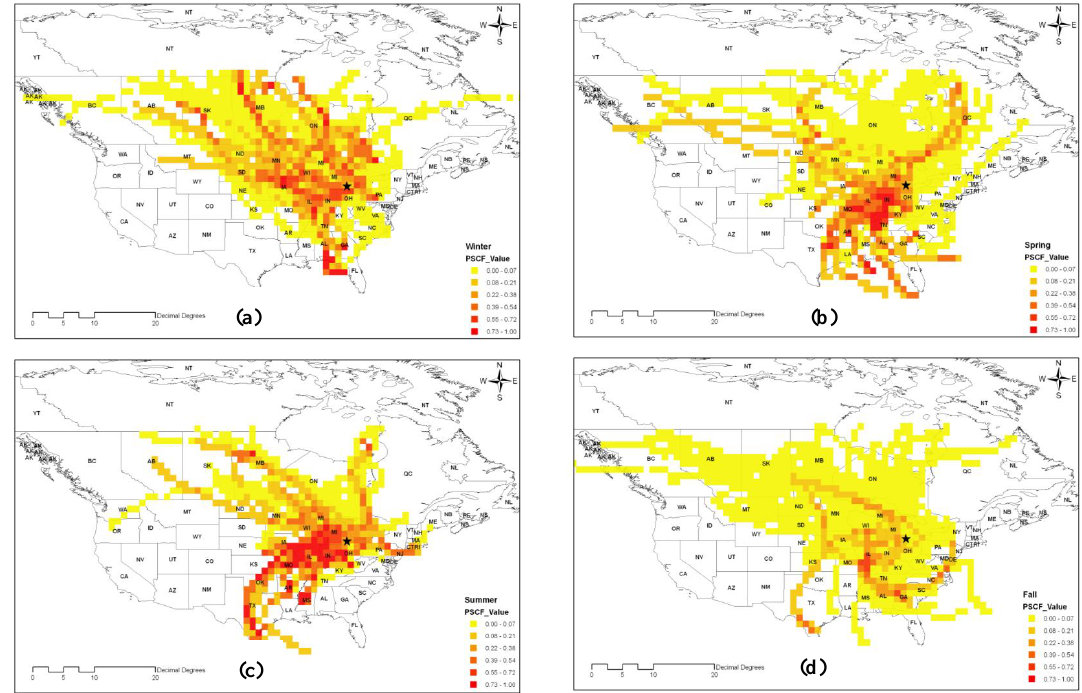
Fig. 5. Weighted PSCF for Windsor in (a) winter, (b) spring, (c) summer and (d) fall, using the annual mean of 2.02 ng/m 3 .